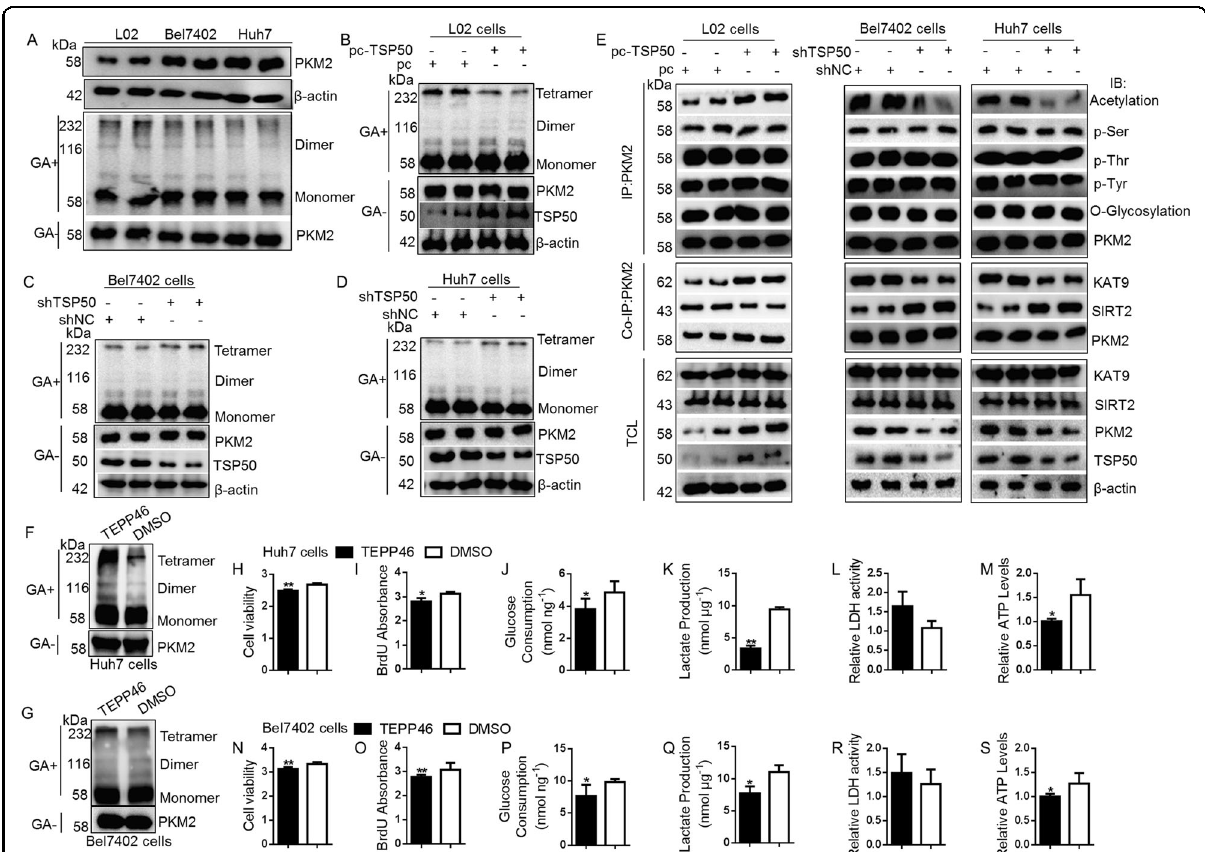
Fig. 5 TSP50-mediated acetylation is essential for maintaining low level of tetrameric PKM2. A Comparison of PKM2 oligomer states in different cells. After extracting the cell protein and treating with glutaraldehyde, immunoblotting was performed with anti-PKM2 for oligomer states. B – D PKM2 oligomer states were detected in TSP50-overexpressed L02 cells and TSP50-knockdowned HCC cells. E TSP50 was overexpressed in L02 cells and knocked down in Huh7 cells and Bel7402 cells. Then, cells were harvested and followed by IP with anti-PKM2, Western blot analysis was performed with anti-PKM2, Acetylation, p-Tyr, p-Thr p-Ser and O-Glycosylation. Interaction of PKM2 with KAT9 and SIRT2 were analyzed by co-IP method. F – S After TEPP46 treatment, the cell viability, BrdU absorbance, glucose consumption, lactate production, LDH activity and ATP levels were analyzed. All aerobic glycolysis values were normalized to protein levels. N = 3 biologically independent replicates. t -Test statistical analysis was used. Data were presented as means ± s.d. *P < 0.05, ** P <